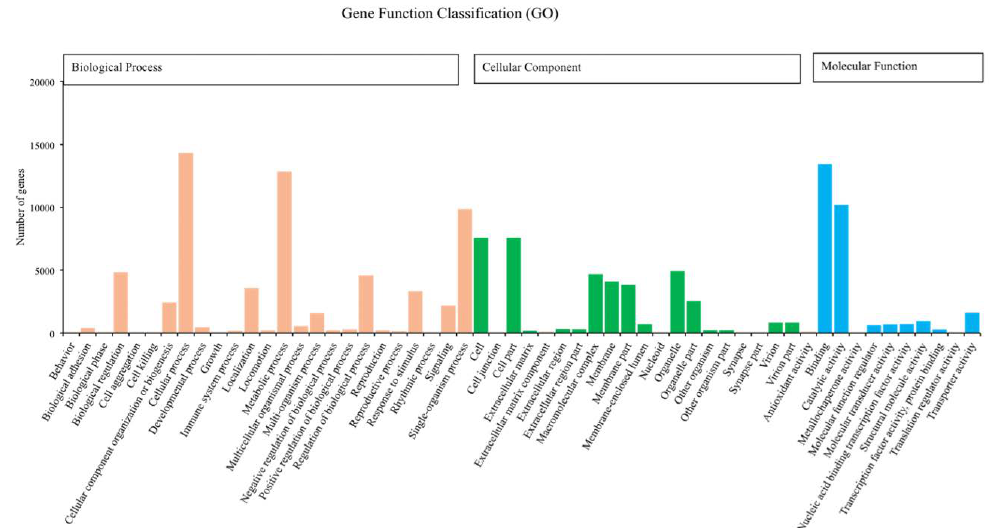
Figure 1. Number of unigenes of Romalea microptera explained and classified by Gene Ontology (GO) data library in different functional groups within the categories of biological process, cellular component, and molecular function.